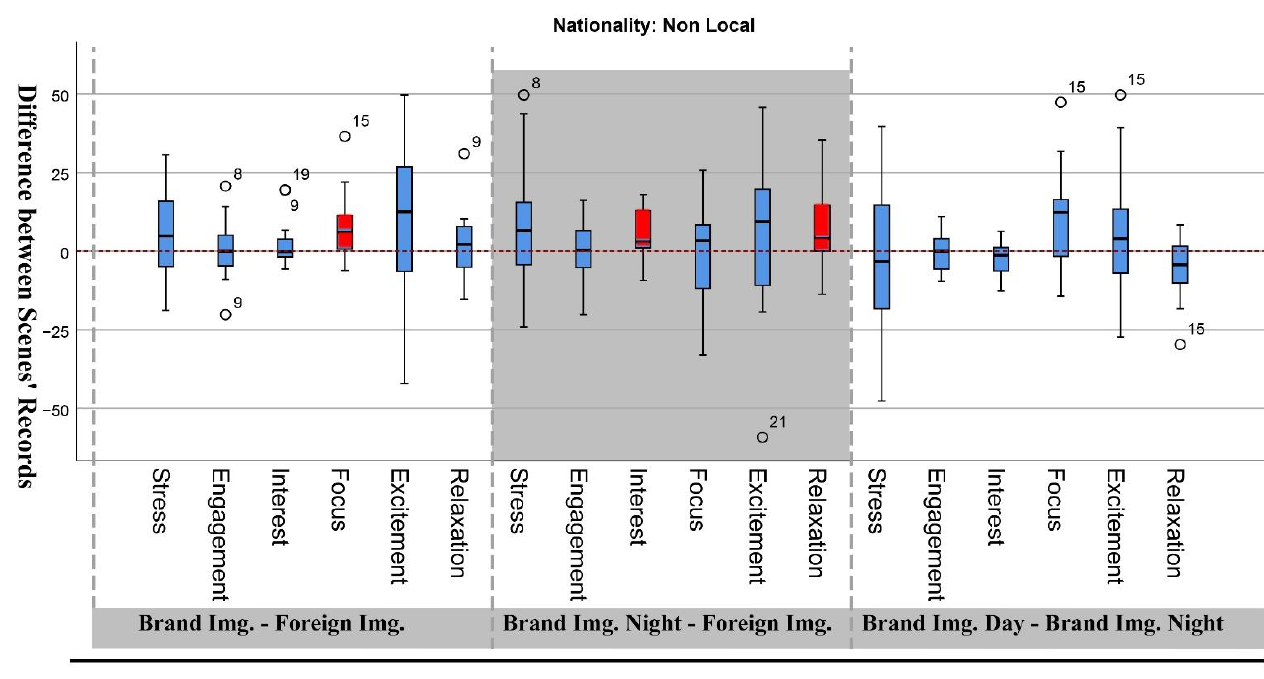
Figure 3. Wilcoxon analysis of EEG data from northern emirates locals.